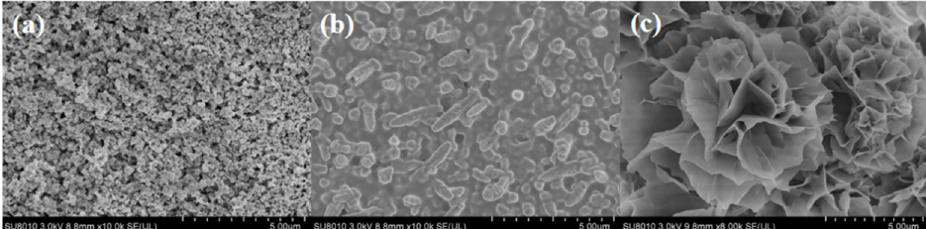
Figure 2. SEM images of ( a ) PASP/NiO/GCE, ( b ) Cu/PTRP/Nafion/GCE, and ( c ) Cu/PNR/GCE.